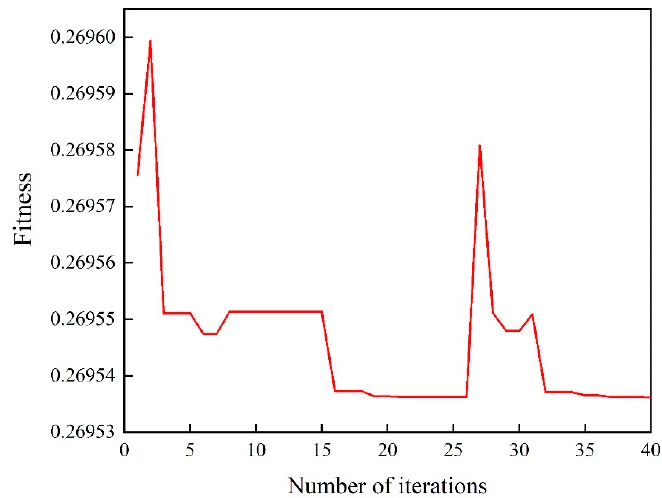
Figure 6. Optimization curve of the function fitness of the model of P min .